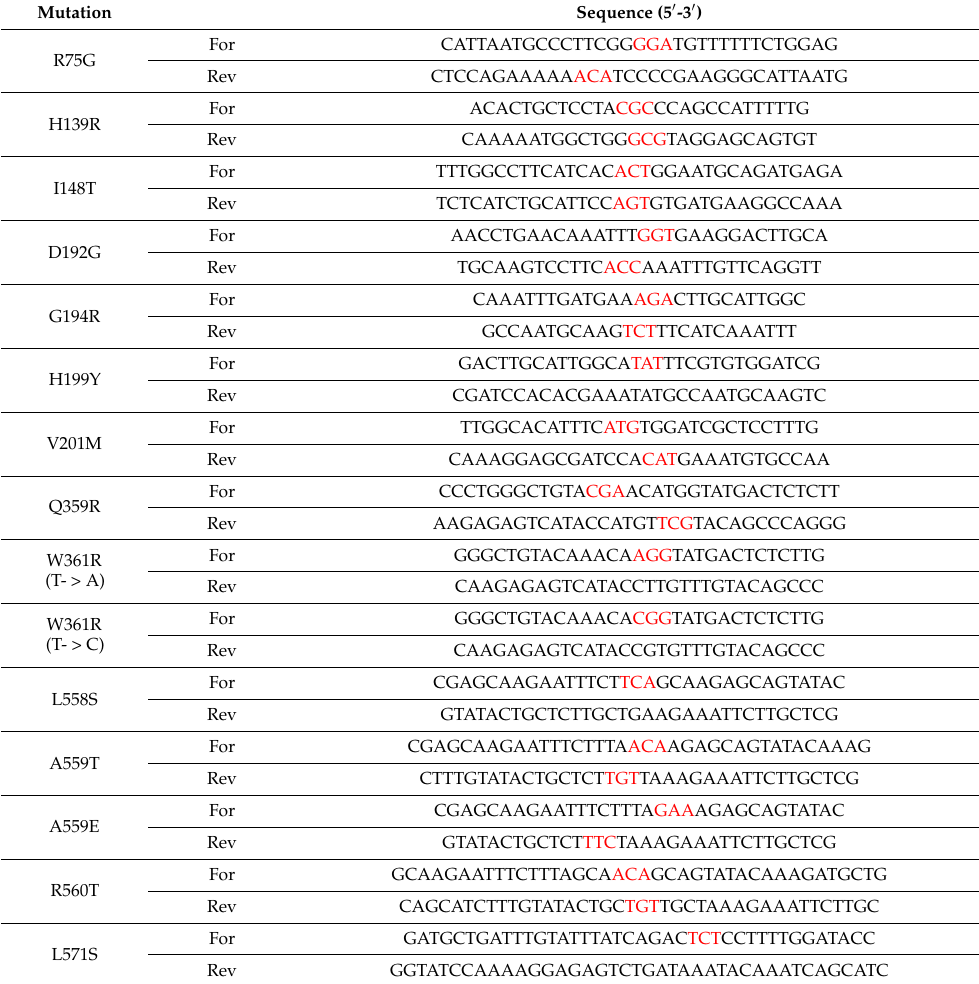
Table 2. List of primers used in site-directed mutagenesis. Highlighted in red the codon for mutation. Mutation Sequence (5 (cid:48) -3 (cid:48)